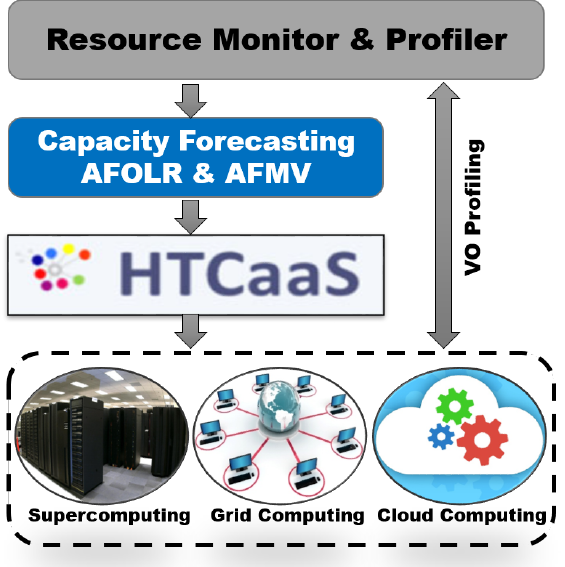
Figure 4. The overall process of identifying and forecasting resource